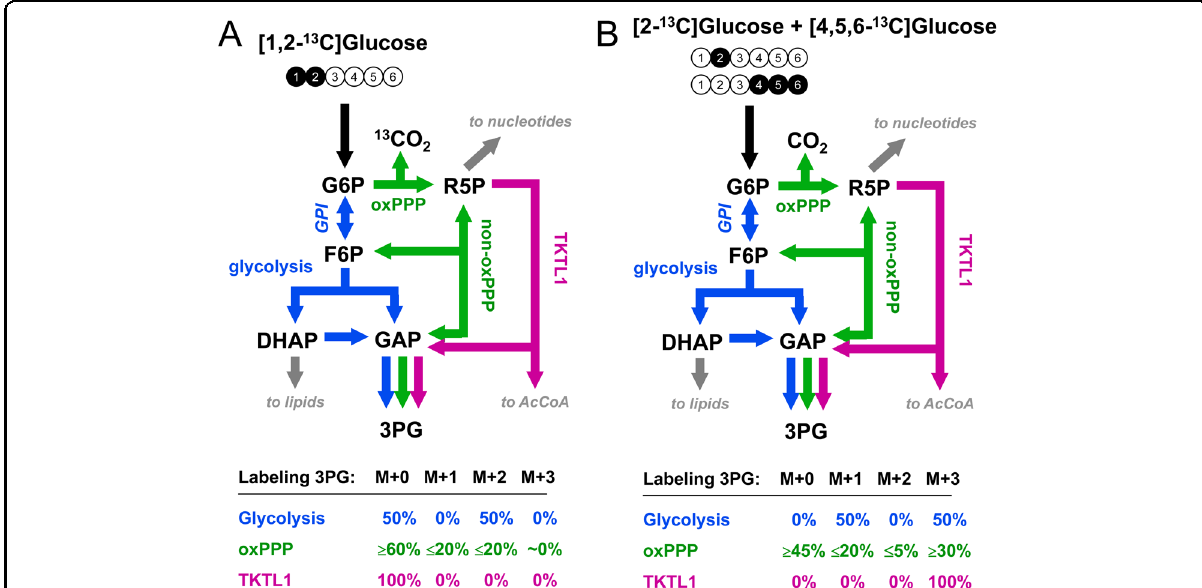
Fig. 6 Two alternative 13 C-glucose-tracing strategies for analysis of metabolic fl uxes in upper metabolism based on mass isotopomer measurements of 3-phosphoglycerate (3PG). a The [1,2- 13 C]glucose tracer allows good resolution of relative glycolysis and pentose phosphate pathway fl uxes. b A mixture of 50% [2- 13 C]glucose and 50% [4,5,6- 13 C]glucose is an improved tracer approach that also allows precise quanti fi cation of the transketolase-like 1 (TKTL1) pathway fl